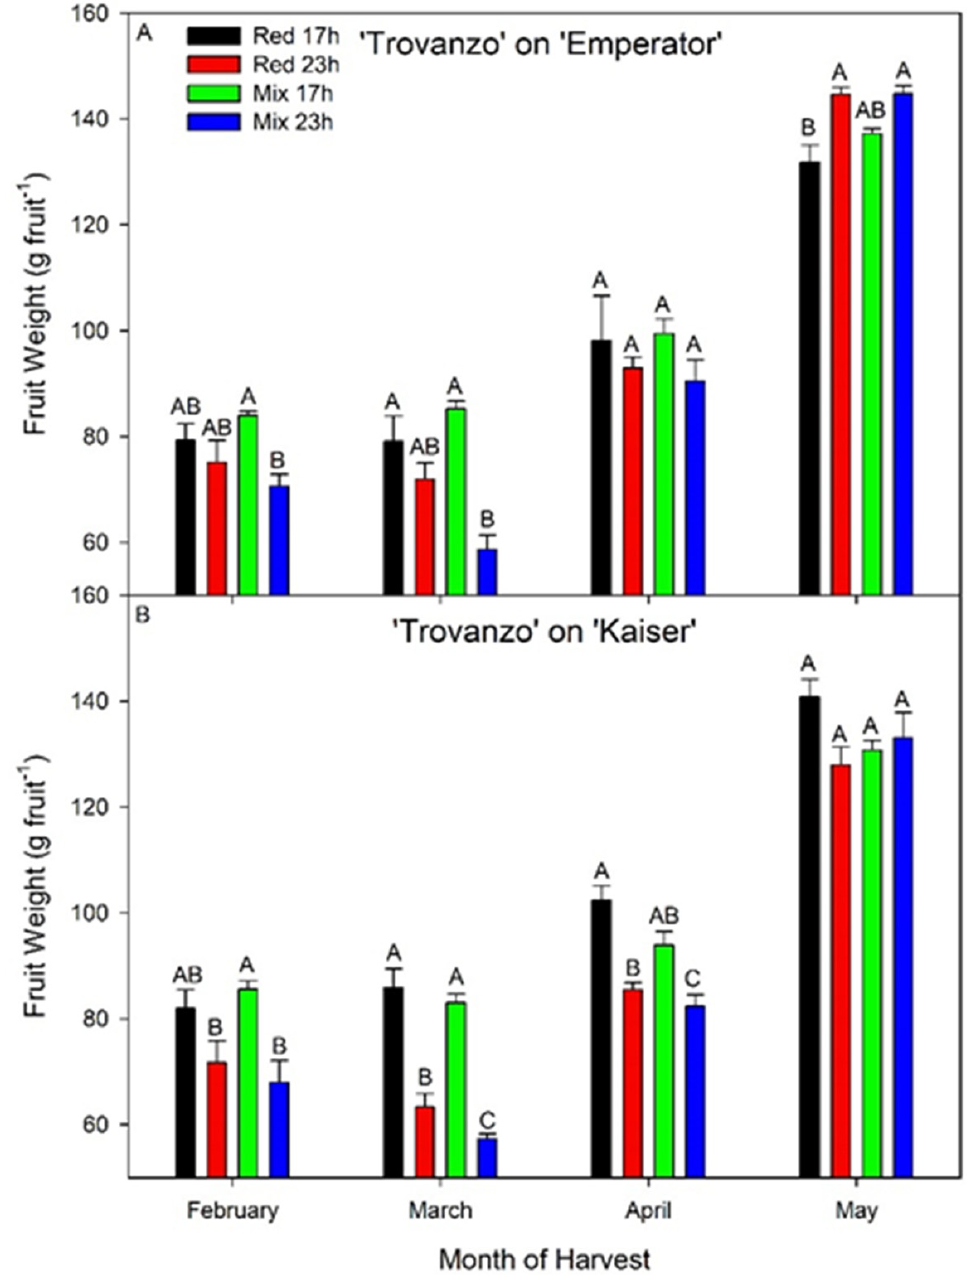
Figure 8. Average fruit weight (size) for cv. ‘Trovanzo’ grafted onto ‘Emperator’ (TE; panel A ) or onto ‘Kaiser’ (TK; panel B ), grown under red 17 h, red 23 h, mix 17 h, and mix 23 h lighting treatments. Monthly fruit number includes the 1st of each month to the last day of each respective month. Values represent the mean ± the standard error of the mean, where n = 4 for TE and TK. Of note, values representing May yield include a strip harvest on 22 May 2019. Within the month and cultivar, letter groups (A, B, C) represent a statistical difference in fruit weight as determined by a two-way ANOVA with a Tukey–Kramer adjustment ( p < 0.05).